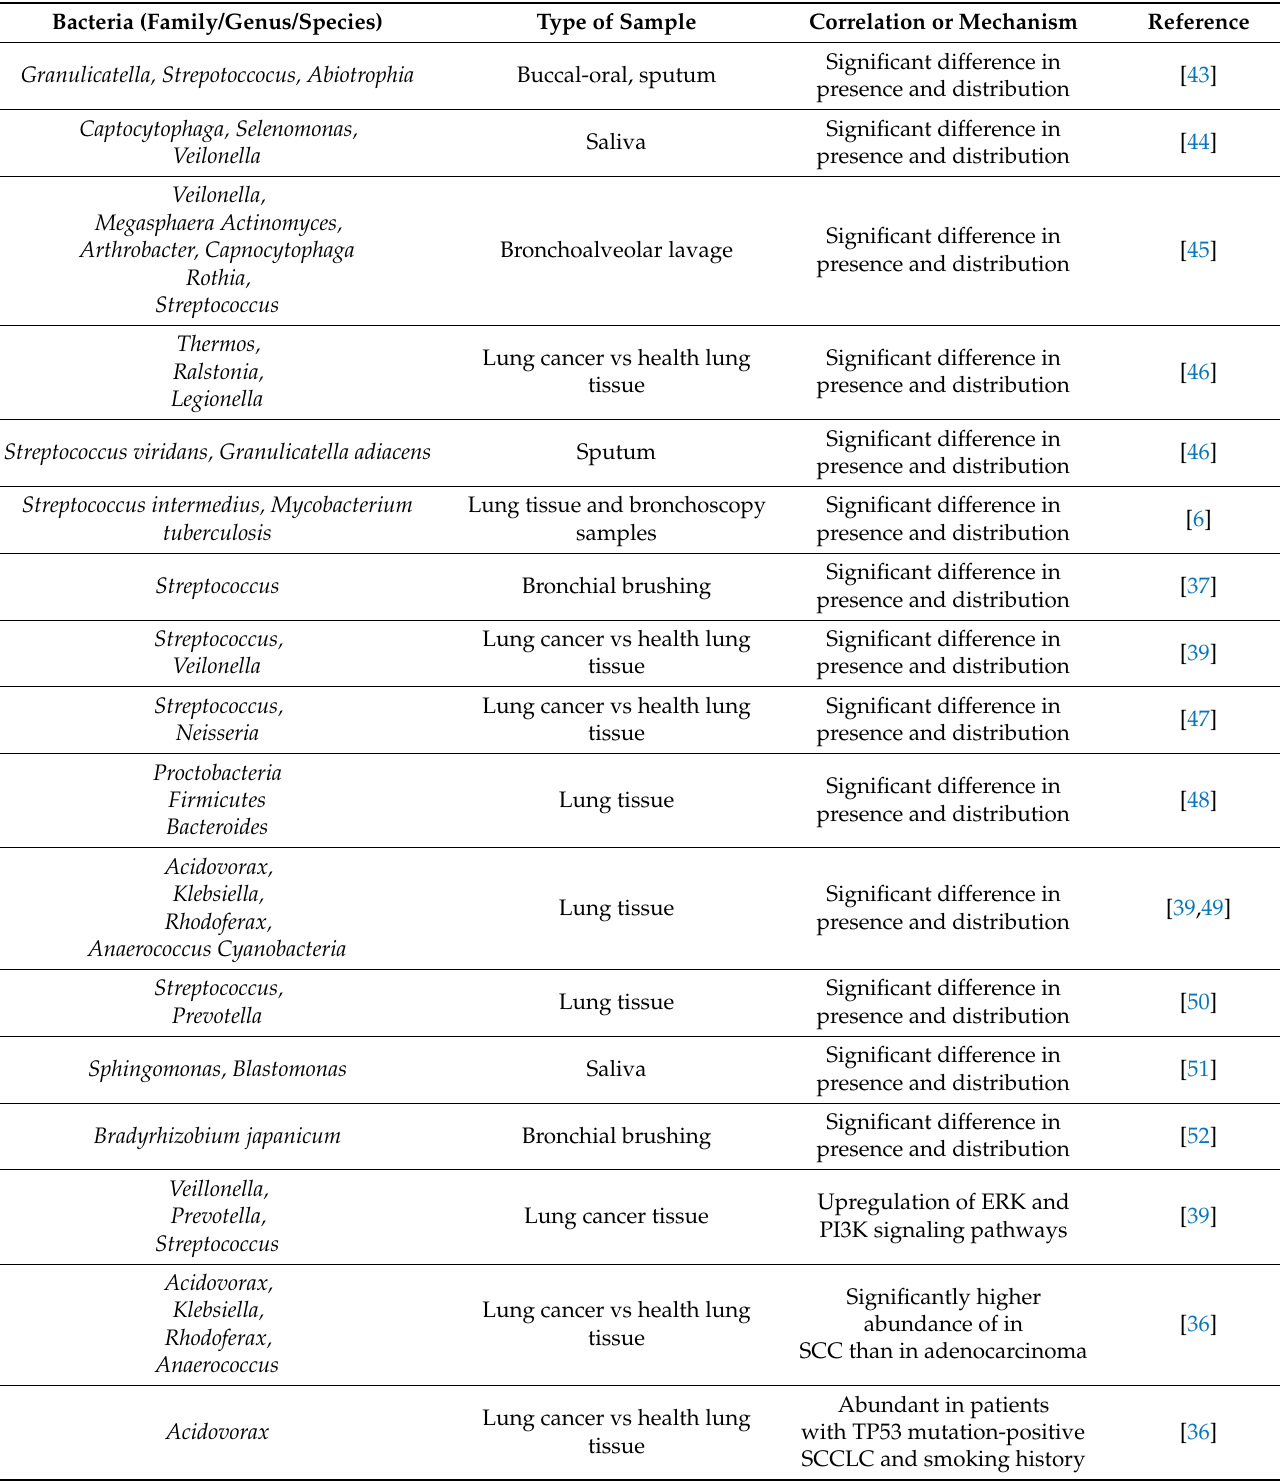
Table 2. Suggested connection between lung microbiome and lung